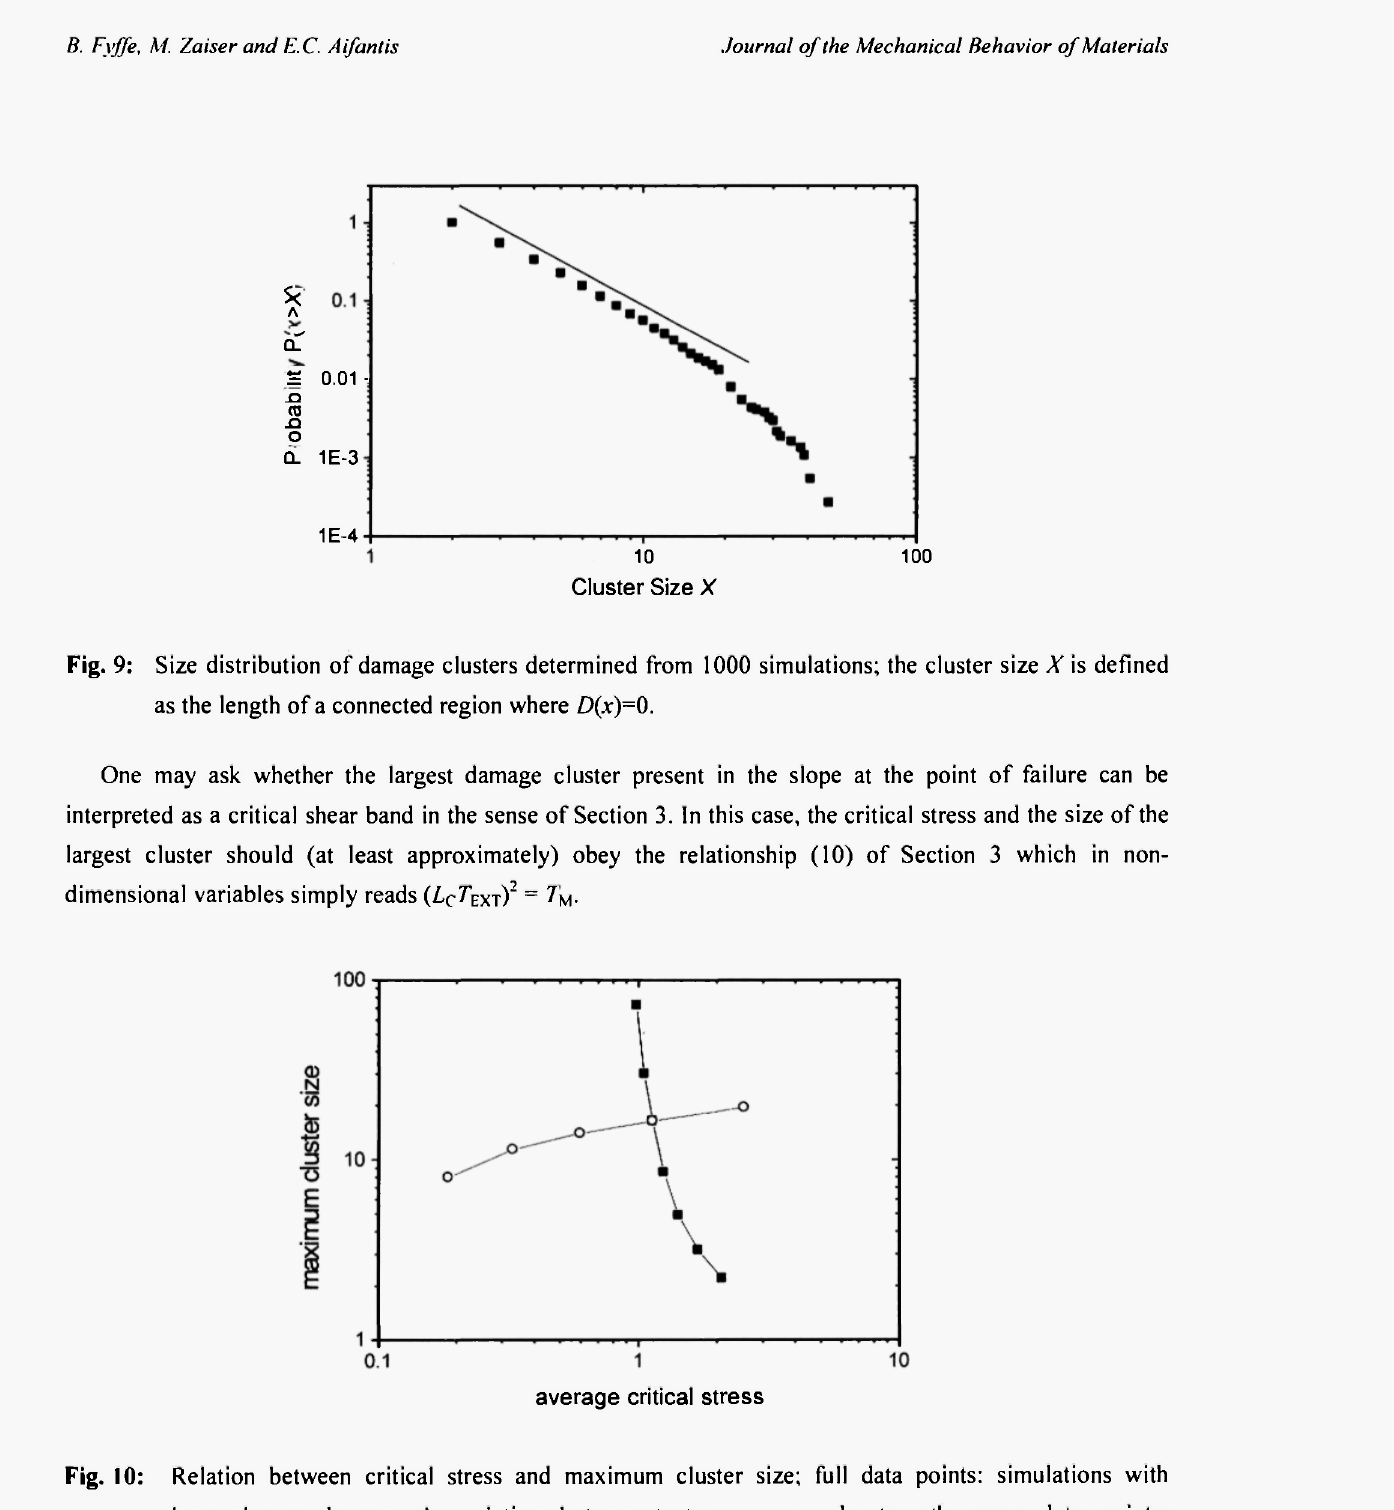
Fig. 10: Relation between critical stress and maximum cluster size; full data points: simulations with increasing peak strength variation but constant average peak strength, open data points: simulations with constant peak strength variation and increasing average